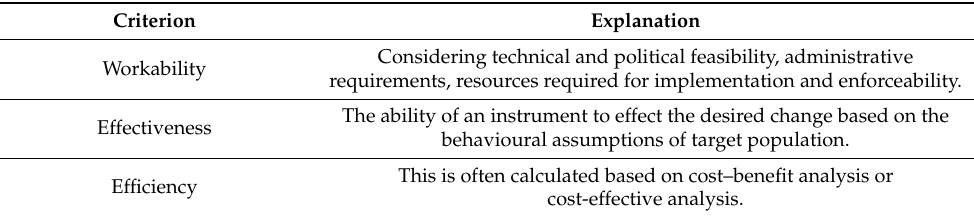
Table 1. Criteria commonly used to compare infrastructure policy instruments (Source: adapted from